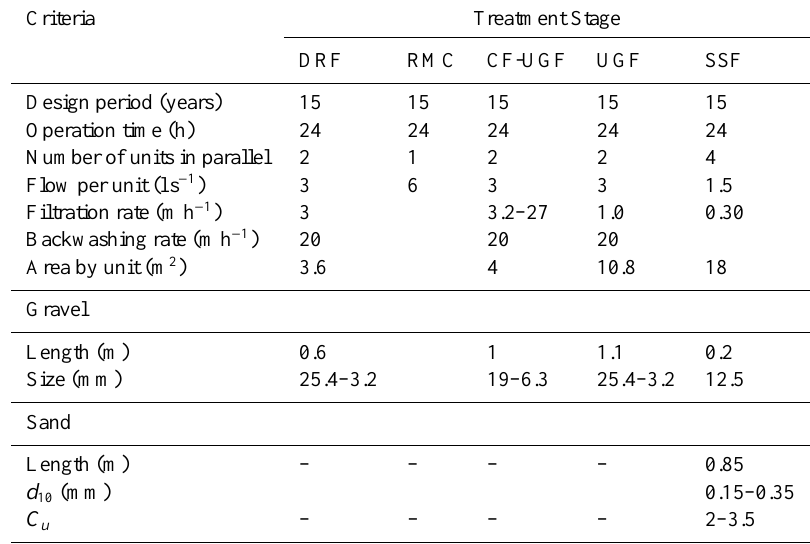
Table 3. Treatment barriers and design parameters.